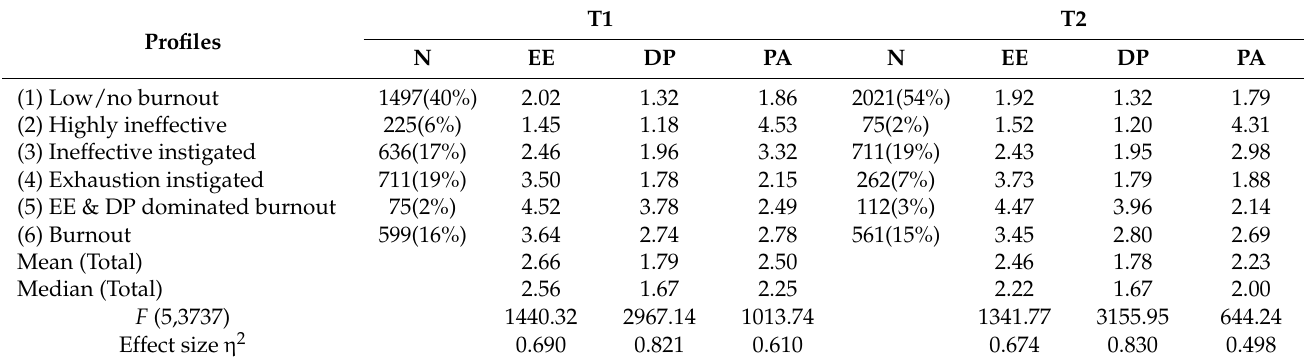
Table 2. Mean of three dimensions in the six latent profiles.